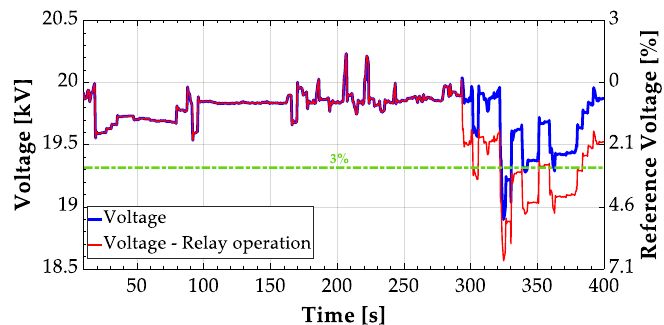
Figure 21. THD of the voltage at the PCC 34.5 kV.